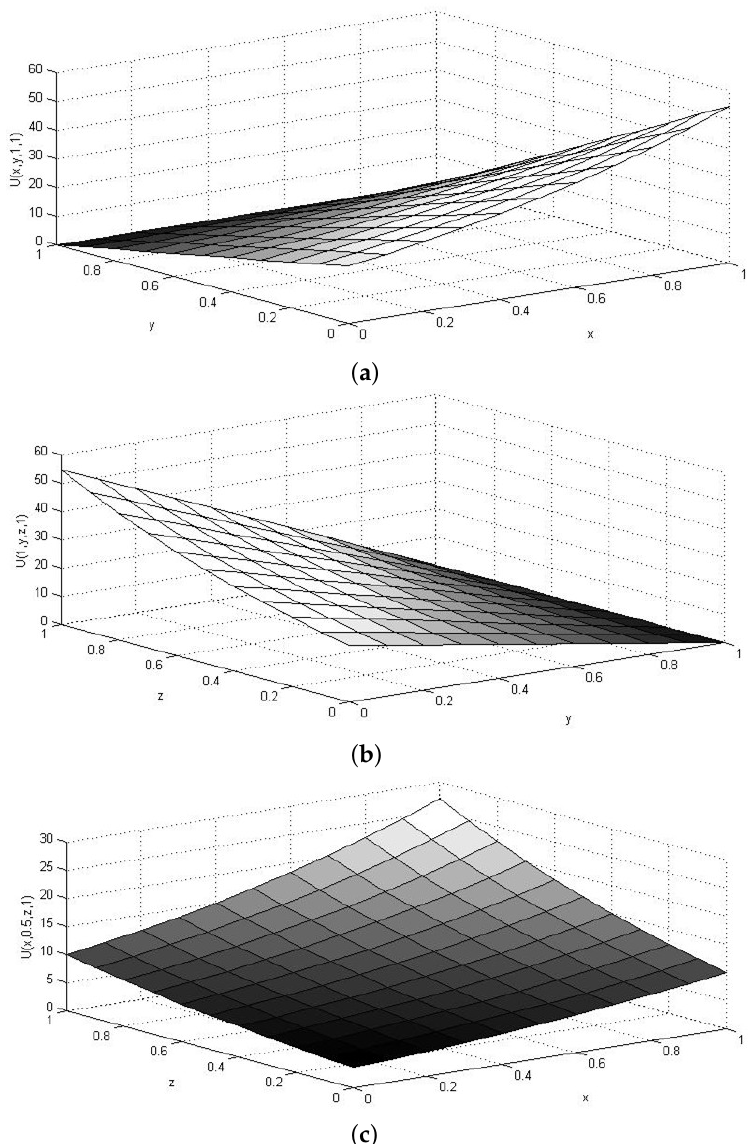
Figure 5. ( a ) HPSTM solution at z = 1 and t = 1. ( b ) HPSTM solution at x = 1 and t = 1. ( c ) HPSTM solution at y = 0.5 and t = 1.